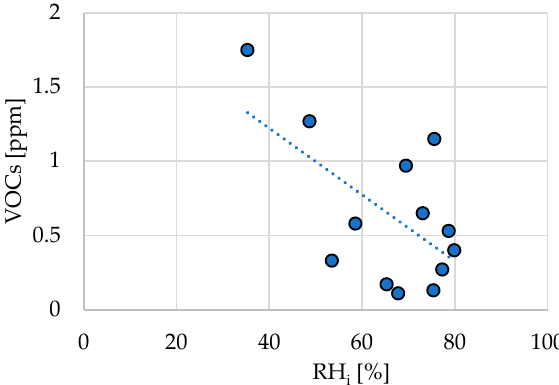
Figure 6. Correlation diagrams between VOC concentration in the mechanical treatment section of A biogas plant and measured RH i parameter with regression line: R 2 = 0.36.